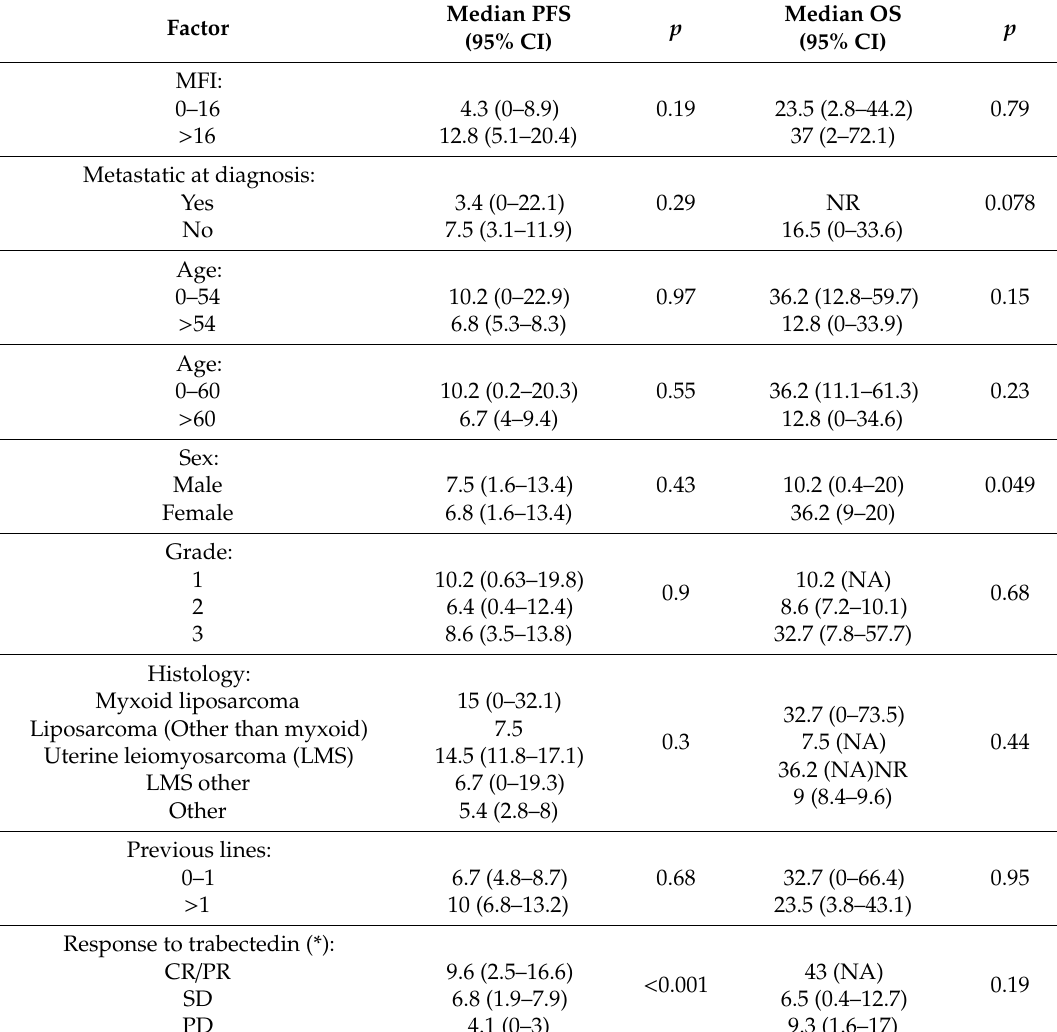
Table A2. Univariate analysis for PFS and